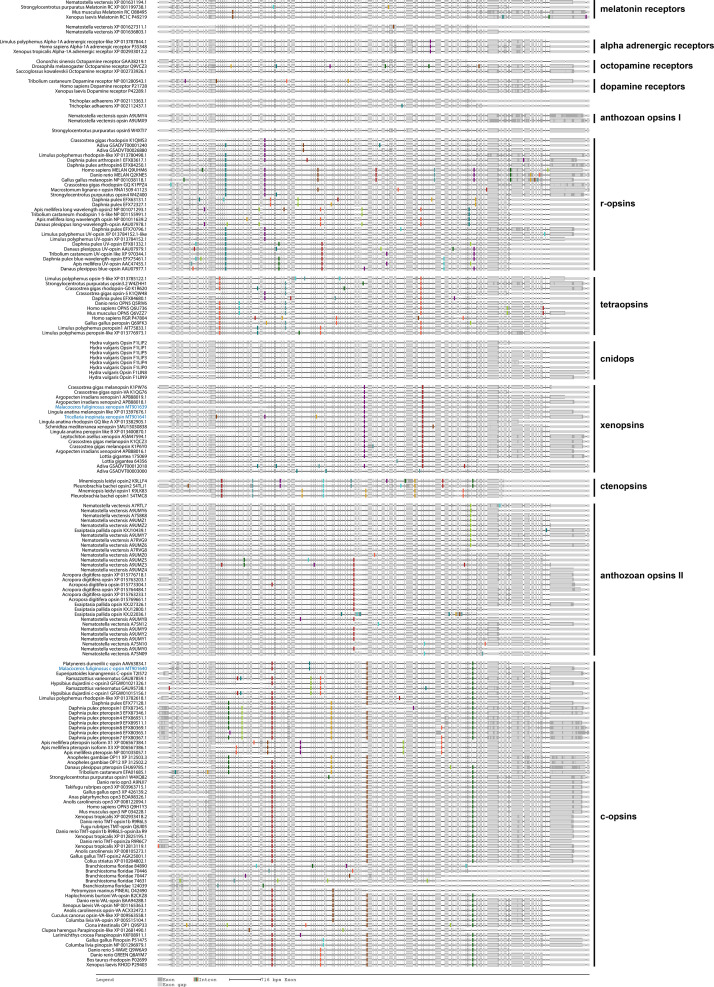
Gene structures of all sequences, which were used for gene tree calculation and for which genomic information was available or generated in this study, mapped on the un-curated protein sequence alignment.The sequences investigated in this study are highlighted in blue.